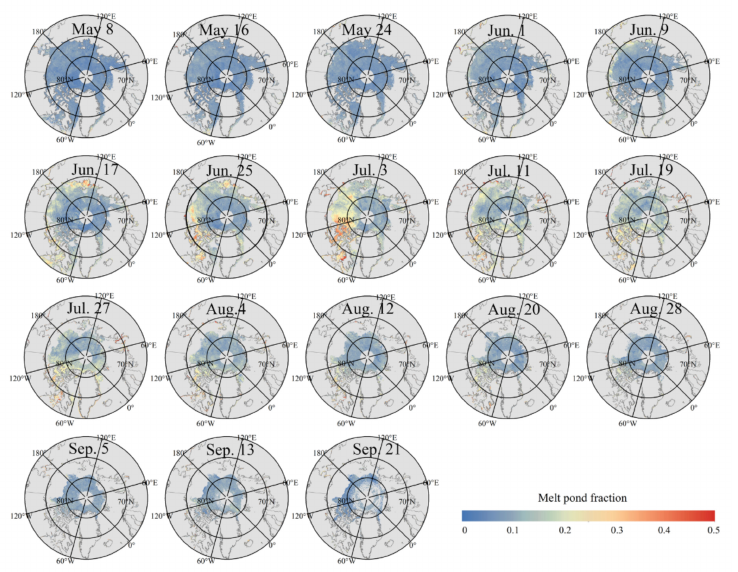
Figure 10. Gap-filled MPF dataset for Arctic sea ice (NENU-MPF dataset) in 2017. For brevity, only the MPFs every eight days from 8 May to 24 September 2017 are